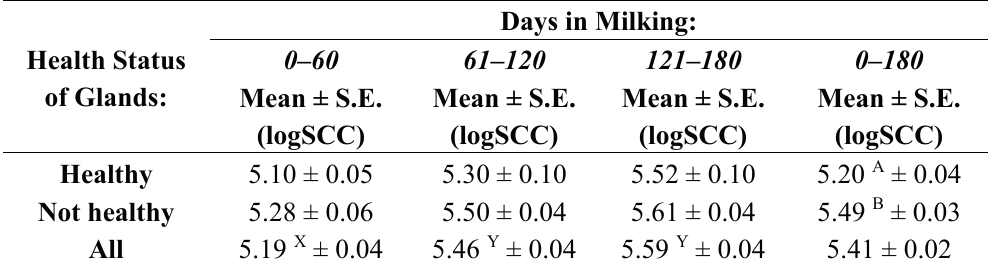
Table 4. Overall means and standard errors of SCC (log) of gland milk samples according to HS and lactation